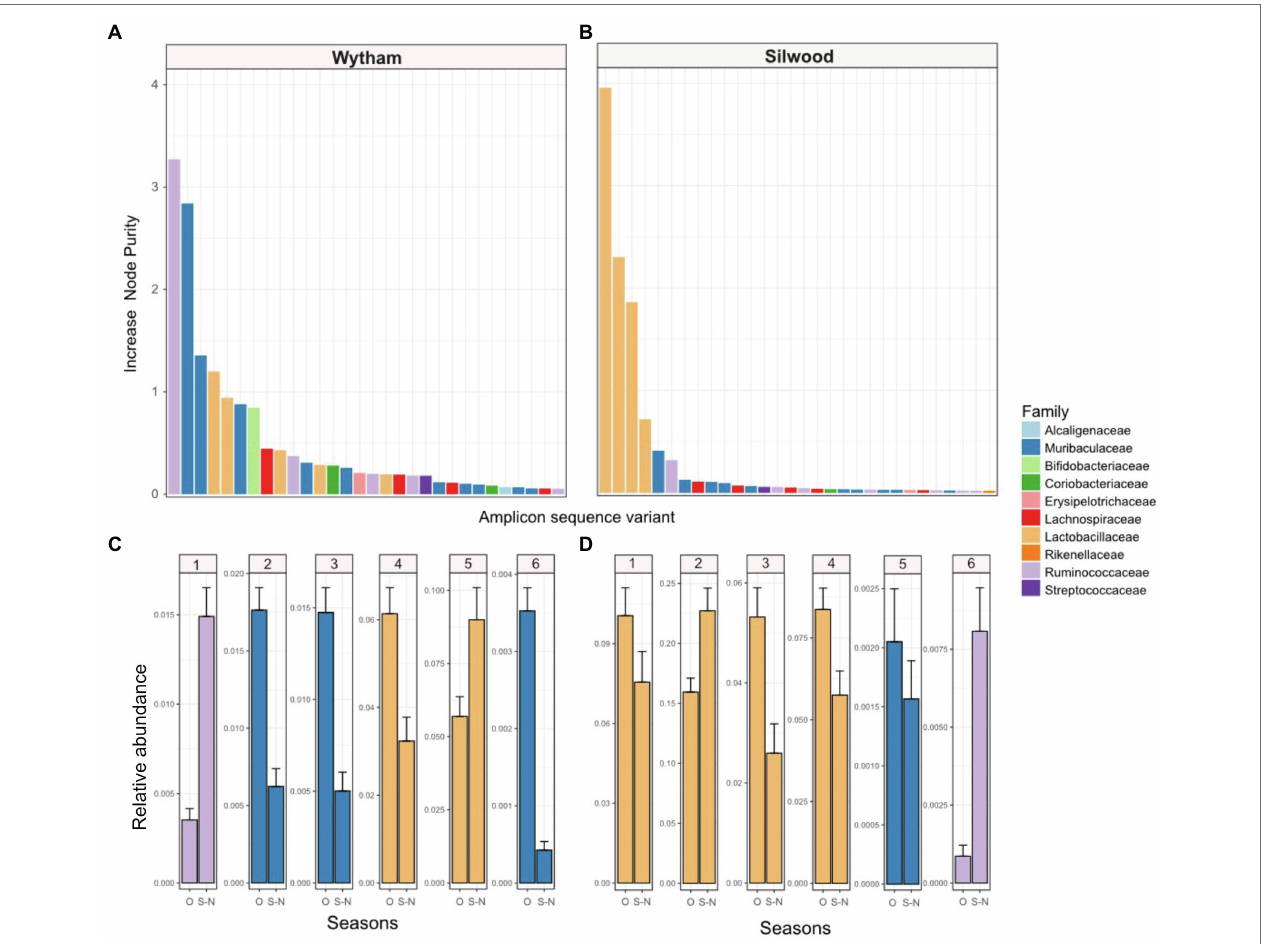
FIGURE 3 | The importance of bacterial taxa in driving consistent seasonal patterns in PC1 (first axis of a Bray-Curtis PCoA) in two wild wood mouse populations. Random forest regressions (RFR) were used to identify bacterial amplicon sequence variants (ASVs) important for predicting PC1, which has a strong seasonal signal, in each population. IncNodePurity” was used as a measure of feature importance in models, and the top 30 ASVs those with the (highest IncNodePurity) are shown for each population (A) Wytham and (B) Silwood, coloured by the bacterial family they belong to. The relative abundance (mean ± SE) of the top six ASVs in each population, (C) Wytham and (D) Silwood, are shown in September-November (S-N) compared to all other months